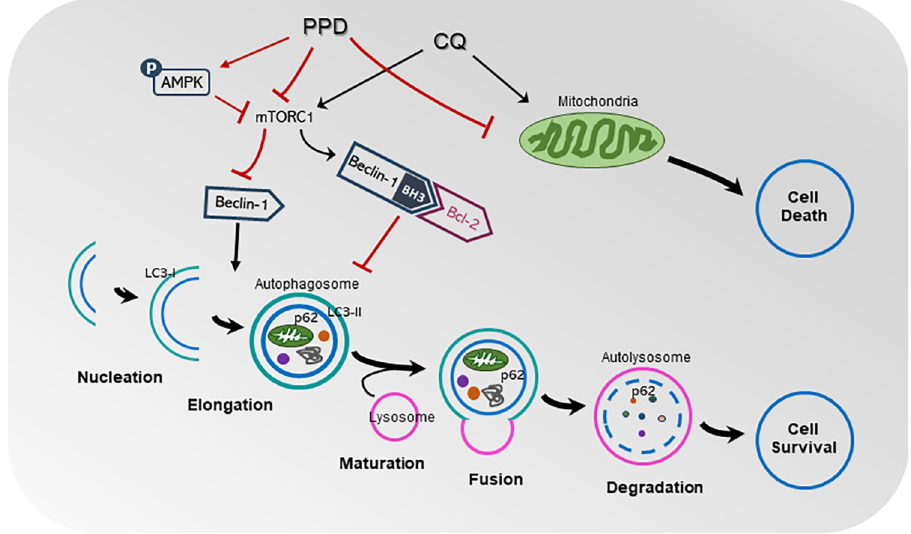
Fig 8. Schematic representation of effect of protopanaxadiol (PPD) on crosstalk between autophagy and apoptosis in chloroquine-treated adult retinal pigment epithelial (ARPE)-19 cells. PPD activated AMP-activated protein kinase (AMPK) activity but inhibited CQ-induced increase of mechanistic target of rapamycin (mTORC) activity and anti-apoptotic protein B-cell lymphoma 2 (Bcl-2) expression. This action altered CQ-mediated interactions between Beclin-1 and Bcl-2 via Bcl-2 homology region 3 (BH3) domain, to activate Beclin-1. Beclin-1, LC3, and p62 are associated with autophagosome formation and autophagy flux. PPD may act critically on gateway of autophagy and apoptosis intersection in mediating CQ-treated ARPE-19 cell toxicity, restoring normal cellular homeostasis.